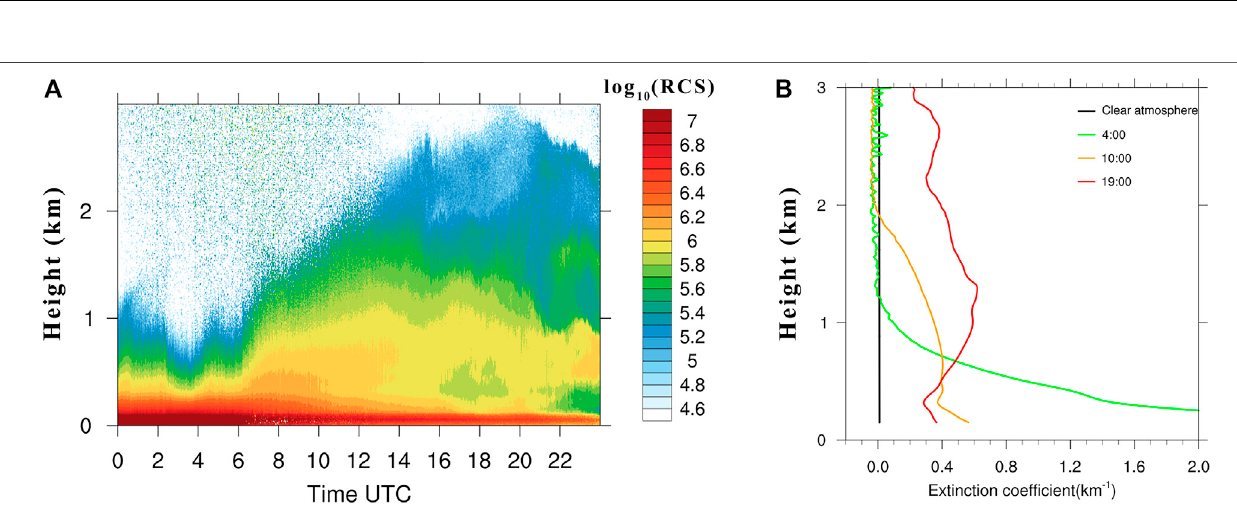
Frontiers in Environmental Science |